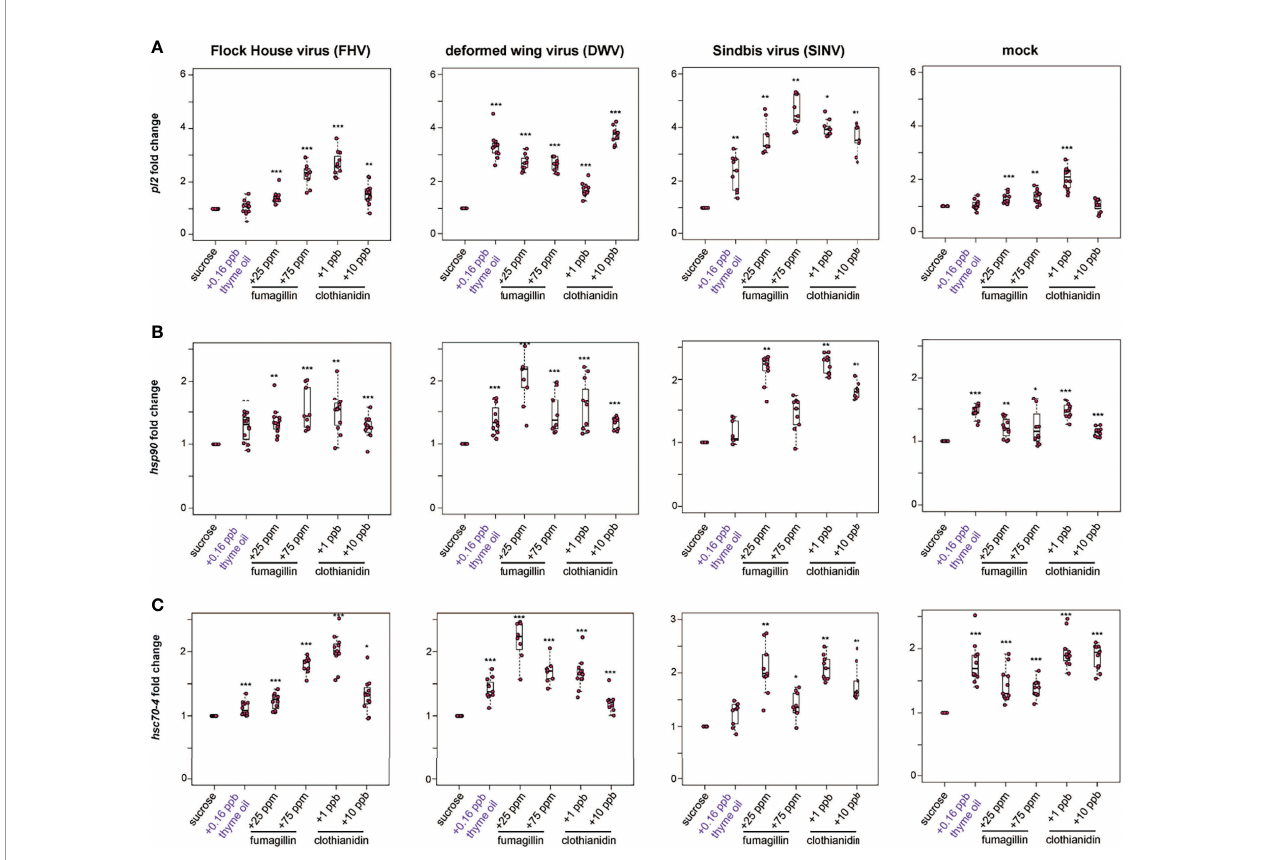
FIGURE 4 | Expression of heat shock protein encoding genes was higher in honey bees fed sucrose syrup containing thyme oil, fumagillin, or clothianidin. The relative expression of three genes encoding heat shock proteins ( pl2, hsp90, hsc70-4 ) was assessed using qPCR in mock or virus-infected bees fed sucrose syrup only or sucrose syrup containing additivities (i.e., thyme oil, fumagillin, or clothianidin). The DD Ct method with normalization to rpl8 in mock or virus-infected bees fed sucrose syrup diet was utilized to determine the relative gene expression. (A) Protein lethal(2)essential for life-like (pl2) expression in virus-infected bees (i.e.,